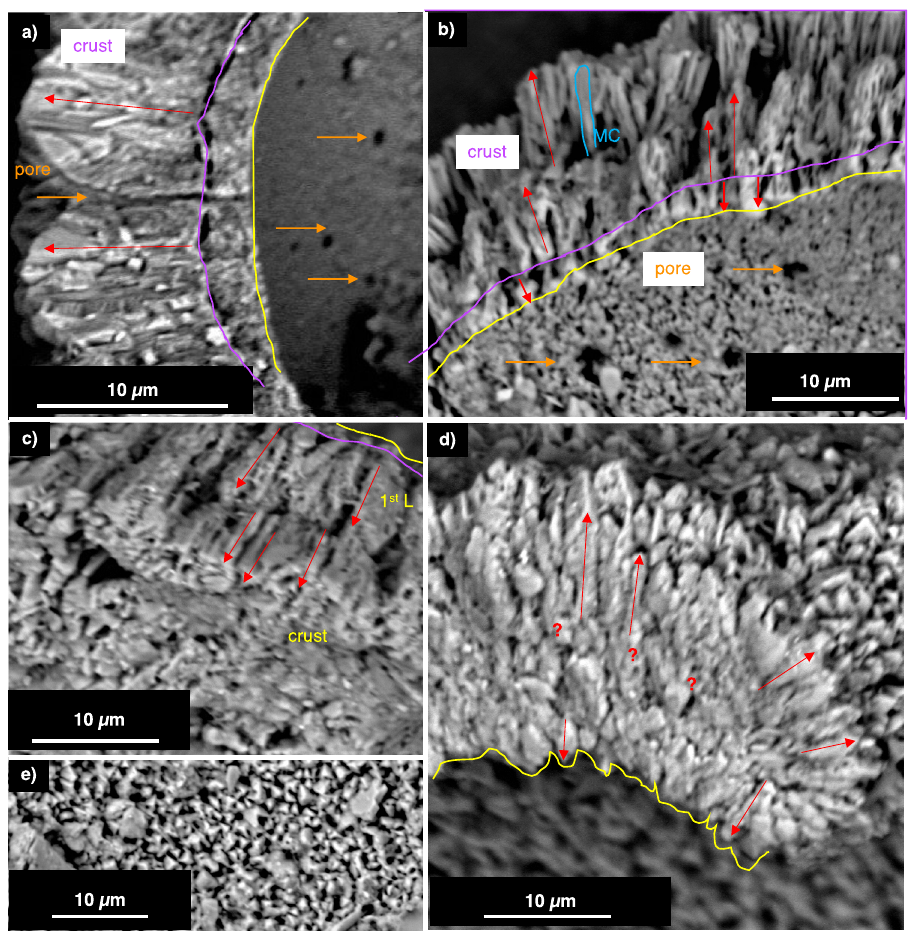
Fig. 10 Diagenetic alteration of N. pachyderma shells. a Pristine shell with secondary calcite crust and smooth shell interior. b , c Shell affected by initial dissolution, showing widened pores and especially at the border of previously existing organic sheets large cavities. d , e Shell with authigenic calcite on the exterior and interior ( e ) surface and penetrating the shell, hereby destroying the original shell structure ( d ), see also the rough interior shell surface (yellow line). PS2185-6. Core depth (cm): a – c 0, d , e 10 cm. Lines indicate the original position of the inner shell surface (yellow), the presumed border between primary shell and secondary crust (purple). Red arrows = growth direction of mesocrystals. Blue line highlights single